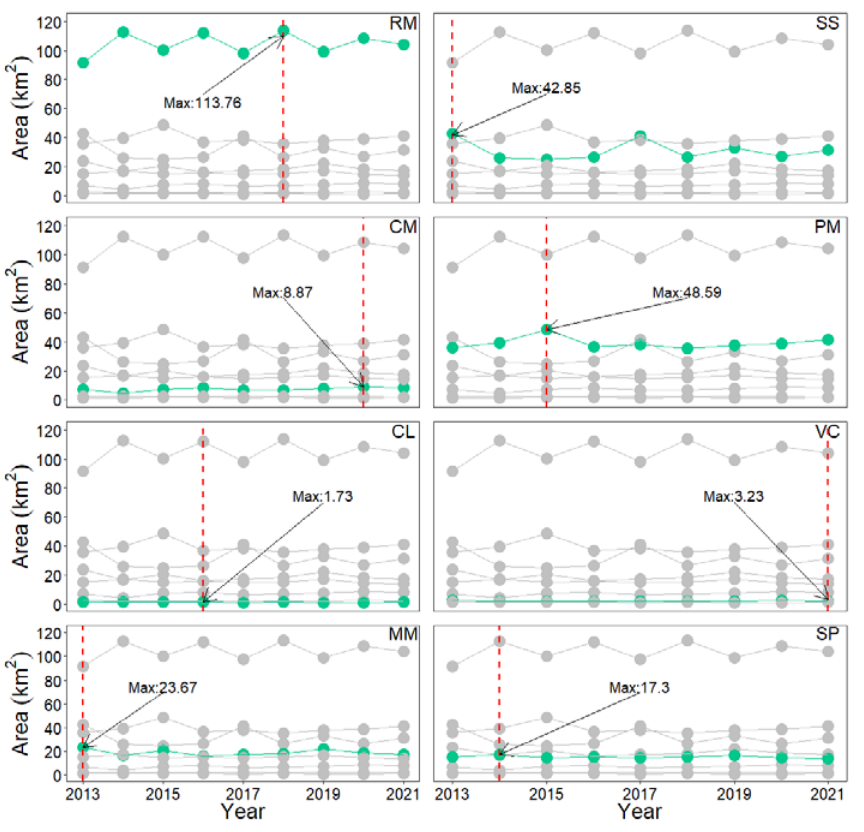
Figure 7. Plot showing inter-annual variations of aquaculture types in Zhao’an Bay from 2013 to 2021.